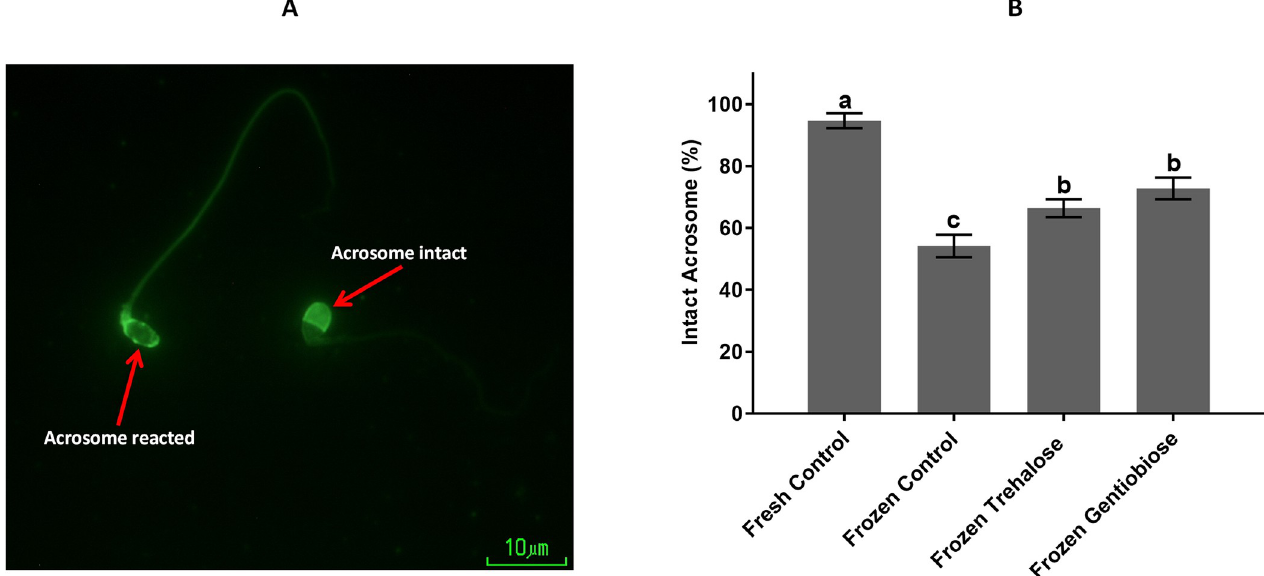
Fig 5. The acrosome integrity was assessed using the fluorescein conjugated lectin Pisum sativum agglutinin (FITC-PSA) staining. Sperm with intact and reacted acrosome was observed (A), and the percentage of intact acrosome significantly differs in all groups (B). The assigned letters a, b and c indicate significant differences (P < 0.05). Values are expressed as mean ± SD, Tukey test; n = 25.